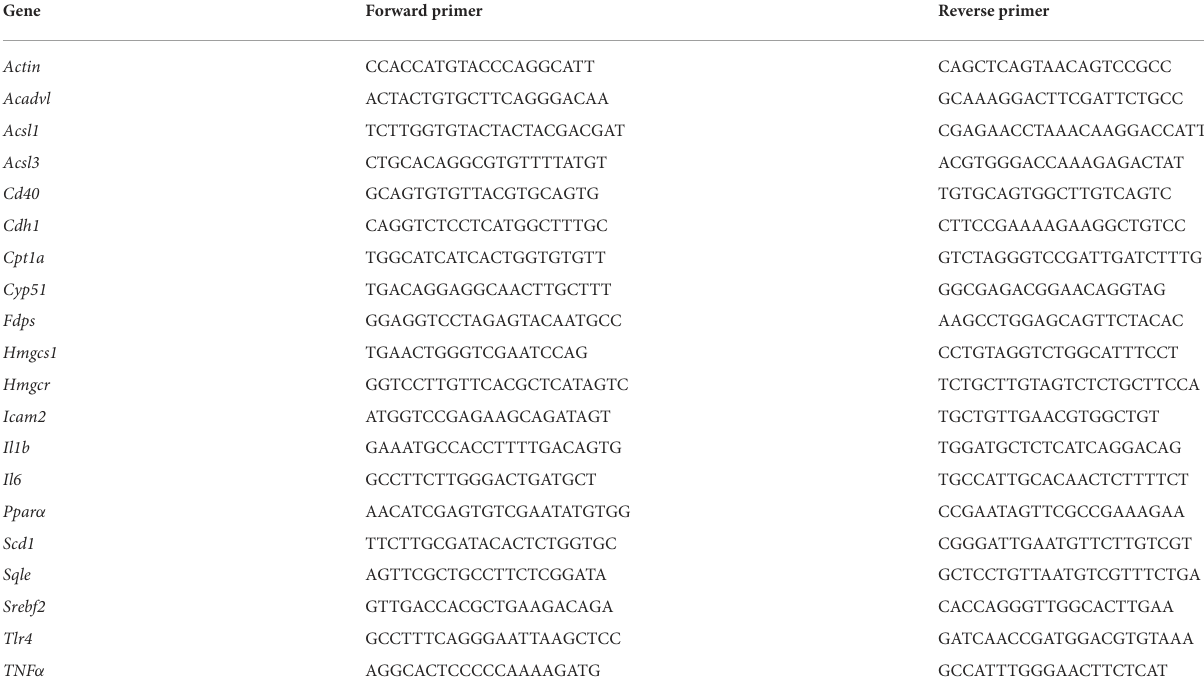
TABLE 2 The primer sequences of